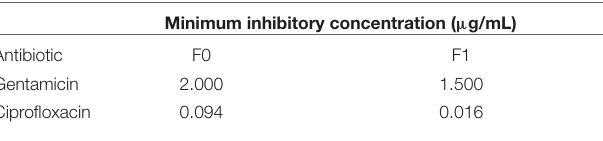
TABLE 1 | Antibiotic susceptibility measurement with